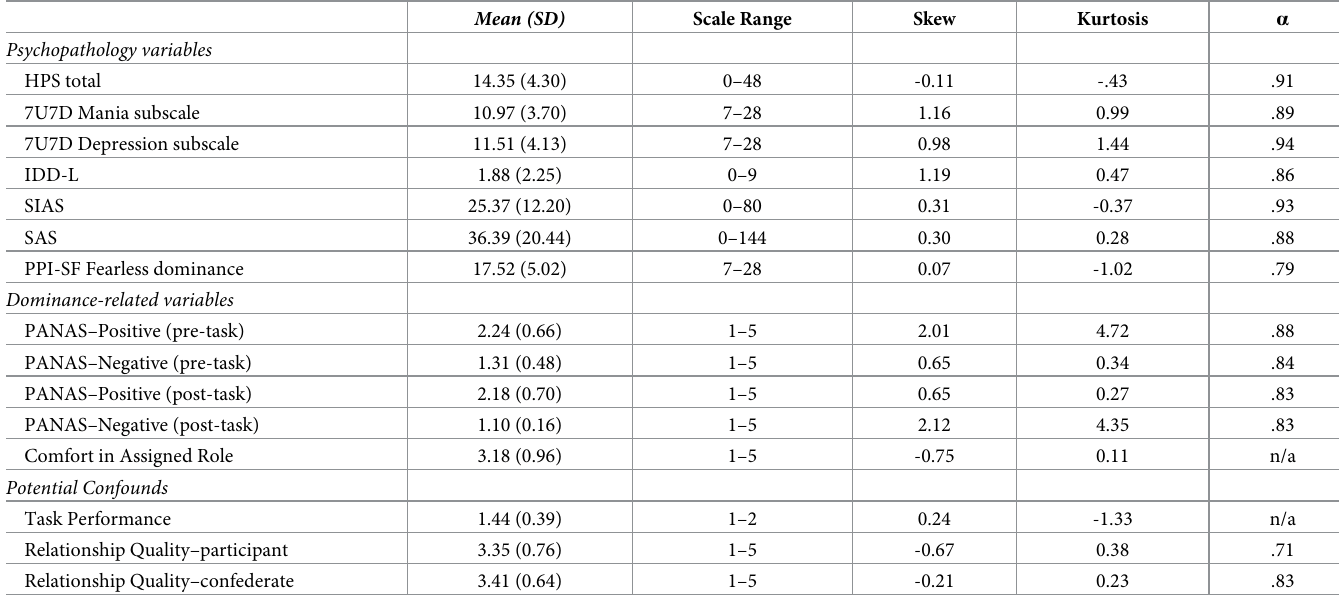
Table 1. Descriptive statistics of key variables (N =